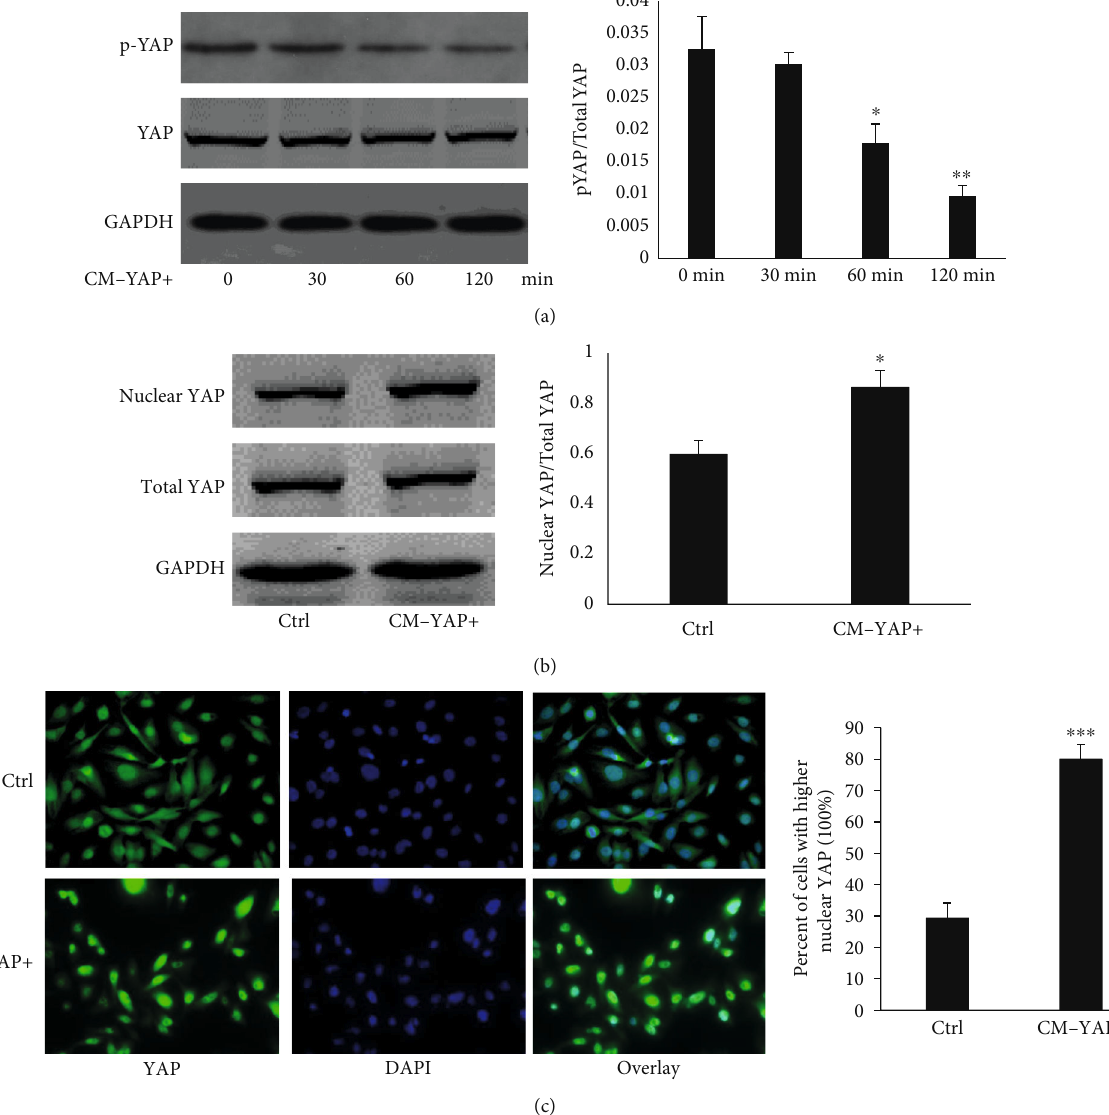
Figure 3: CM-YAP+ activated YAP of HUVECs. (a) HUVECs were starved for 16 hr, then, treated with CM-YAP+ for di ff erent times. Expression of total YAP and phosphorylated YAP in HUVECs were detected by Western blots. Representative results are shown from three independent experiments. ∗ p < 0 : 05 . ∗∗ p < 0 : 01 . (b) HUVECs were starved for 16hr, then, treated with CM for 2 hr. Expression of total YAP and nuclear YAP in HUVECs were detected by Western blots. Representative results are shown from three independent experiments. ∗ p < 0 : 05 . (c) CM-YAP+ induced YAP nuclear translocation is shown in HUVECs. Green: YAP; blue: DAPI. ∗∗∗ p < 0 : 001